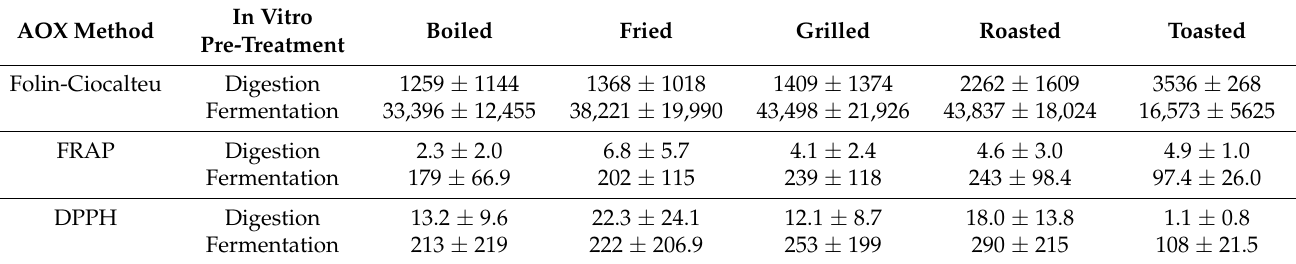
Table 4. Antioxidant capacity measured via Folin–Ciocalteu (mg gallic acid equivalents/kg of food), depending on the type of cooking